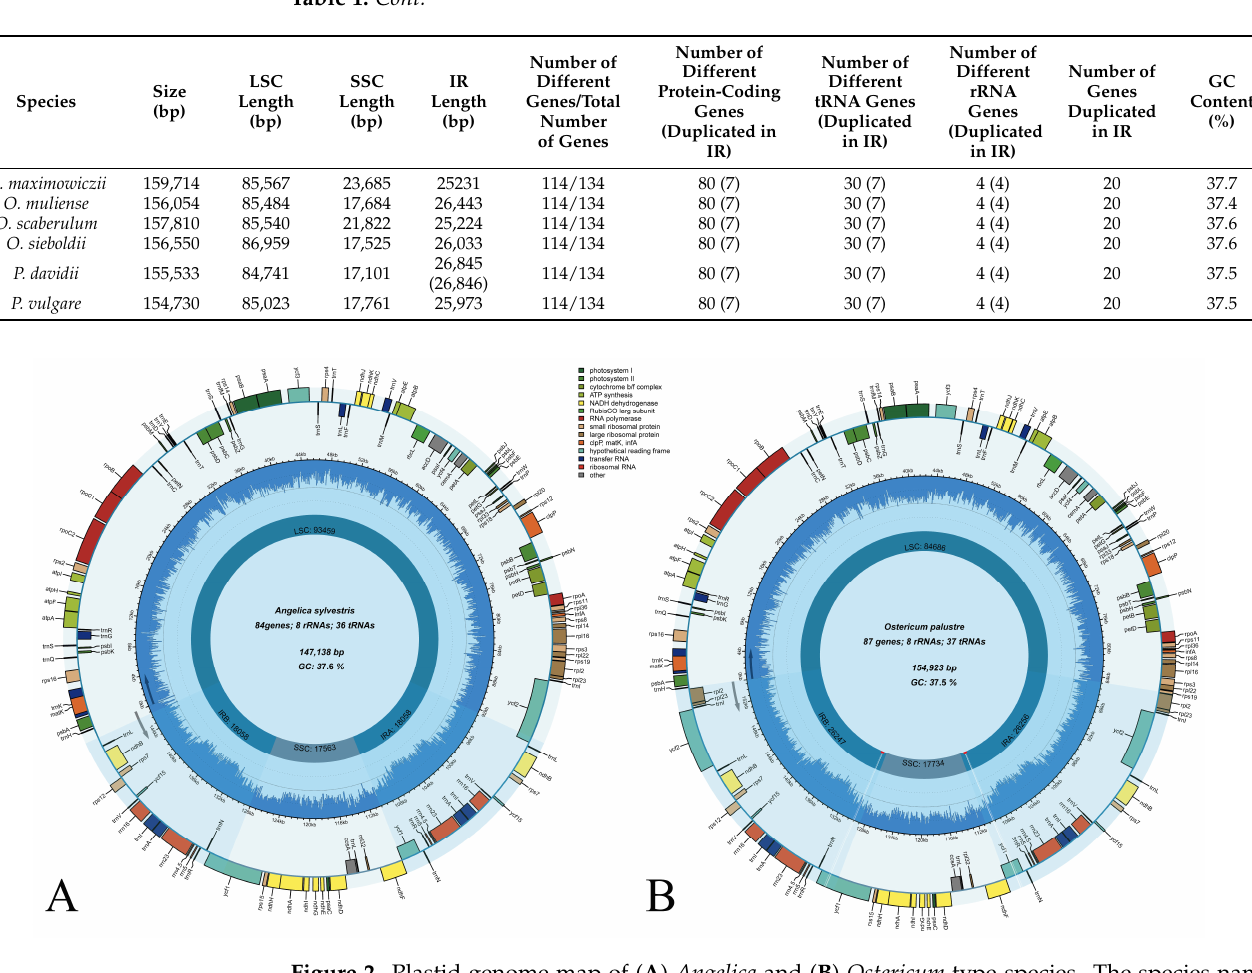
Figure 2. Plastid genome map of ( A ) Angelica and ( B ) Ostericum type-species. The species name and specific information regarding the genome (length, GC content, and the number of genes) are depicted in the center of the plot. The lengths of the corresponding single short copy (SSC), inverted repeat (IRa and IRb), and large single-copy (LSC) regions are shown. Represented with arrows, the transcription directions for the inner and outer genes are listed clockwise and anticlockwise, respectively. The optional shaded area stretching from the inner sphere toward the outer circle marks the IR regions. Genes are color-coded by their functional classification. Table 2. List of genes and pseudogenes in Angelica and Ostericum